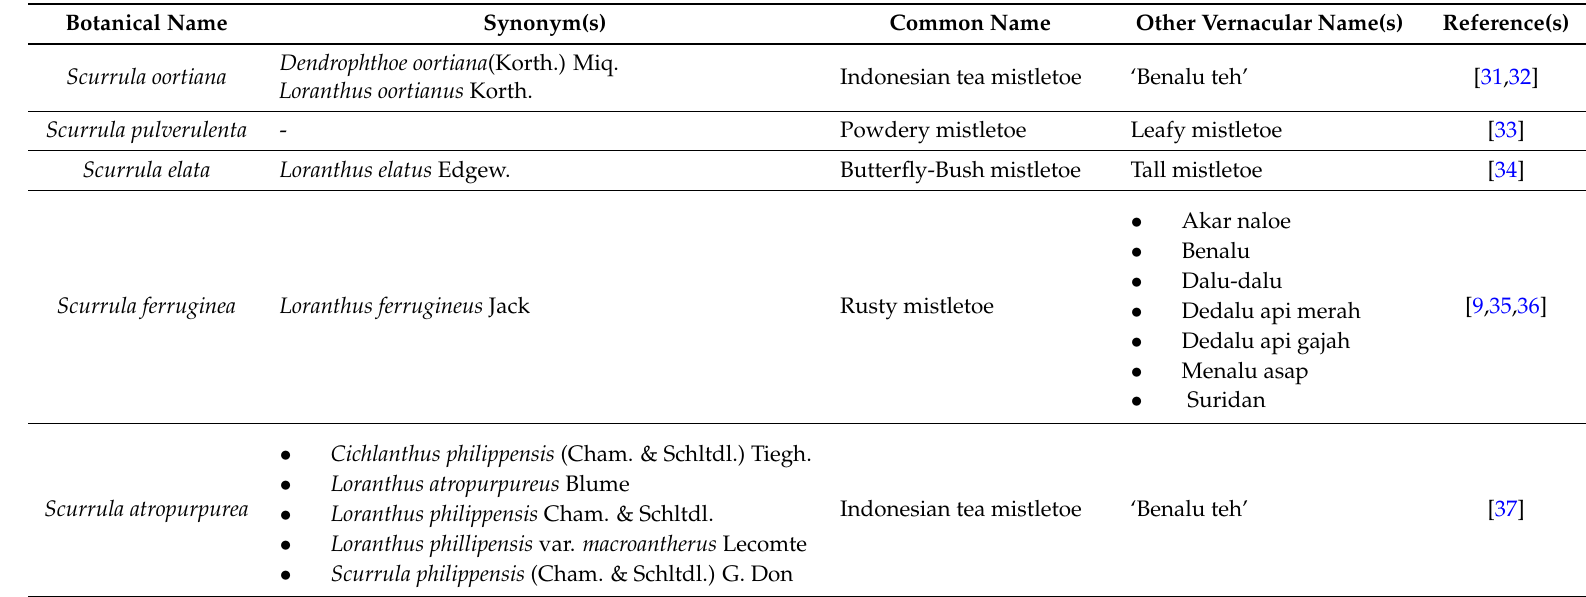
Table 2. Vernacular Names of Scurrula